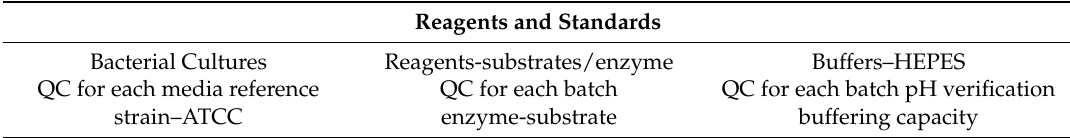
Table 1. Parameters for QA/QC of the biological and chemical factors for the biosensor assay.